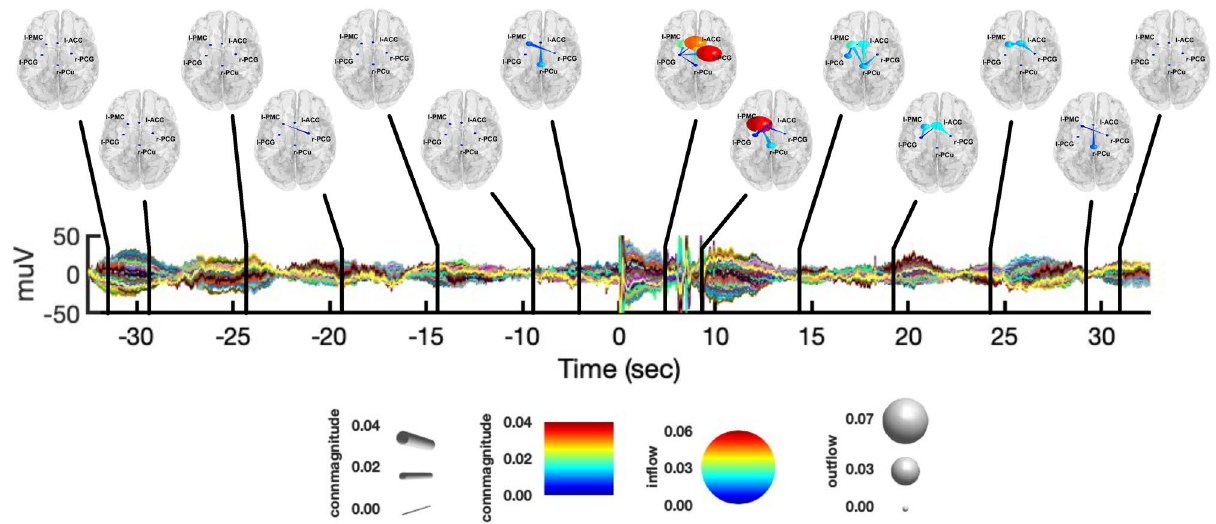
Figure 5. Graphical representation of causal interactions between the network nodes (i.e., l-PCG, l-PMC, r-PCu, l-ACC and r-PCG) integrated in the δ band, during both the resting-state from − 35 s to − 5 s and CPT from + 5 to + 35, with respect to the CPT start. Nodes are reported in a standard template, with their corresponding label. Node size represent information outflow, whereas node color represents information inflow. The edges represent connections between nodes, whose color and size encode connectivity magnitude. The directionality of connections is given by the direction were the edges taper.